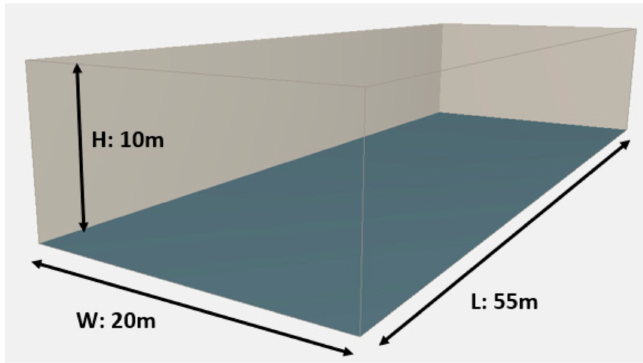
Figure 1. Sawtooth roof (Left), skylight (Middle) and monitor (Right).